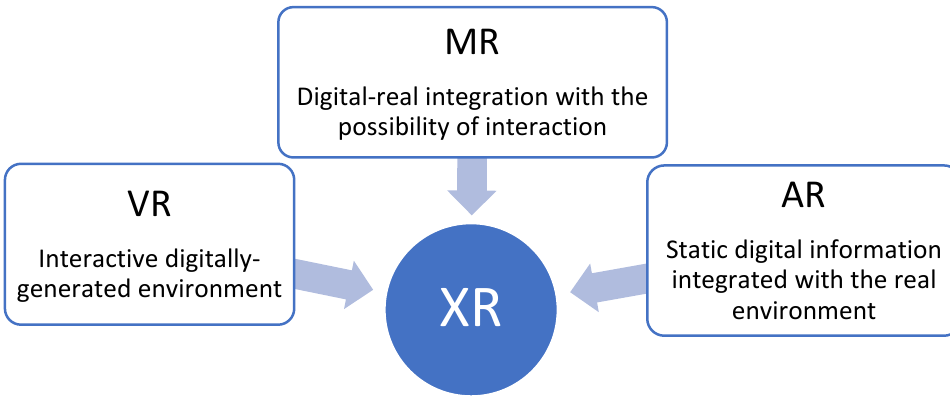
Figure 2. Representation of the collective term extended reality (XR).